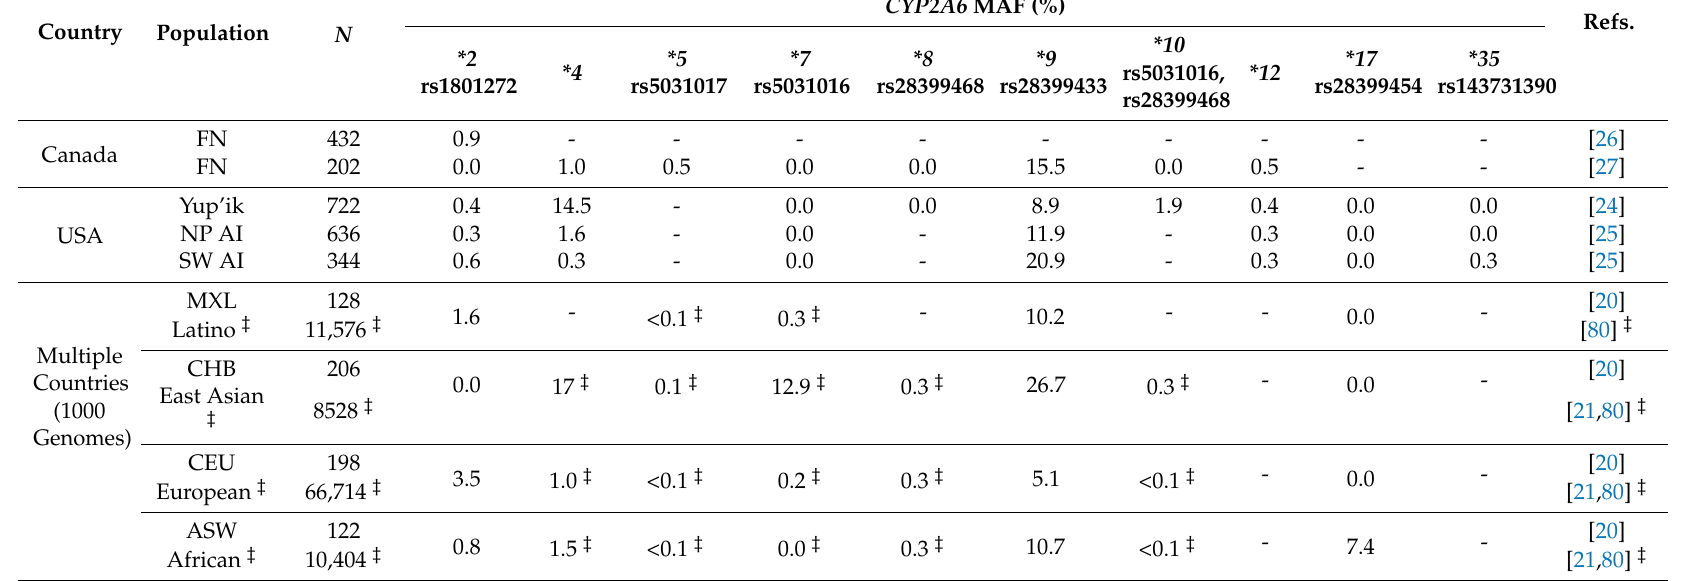
Table 4. Comparison of CYP2A6 allele frequencies in Indigenous North American populations to global populations from the 1000 Genomes Project [20]. N represents the number of alleles. Global populations are abbreviated as follows: African Ancestry in Southwest US (ASW); Utah residents with Northern and Western European ancestry (CEU); Han Chinese in Beijing, China (CHB); Mexican Ancestry in Los Angeles, California (MXL). For alleles not captured by 1000 Genomes (noted by ‡), the frequencies were extracted from Exome Aggregation Consortium [80] and for alleles defined by multiple variants, the frequencies reported in Zhou et al. [21] using LDLink software [81] were used. Global population data for CYP2A6*35 was not included because it is currently difficult to accurately genotype due to the high homology to CYP2A7 , which can result in false positives and false